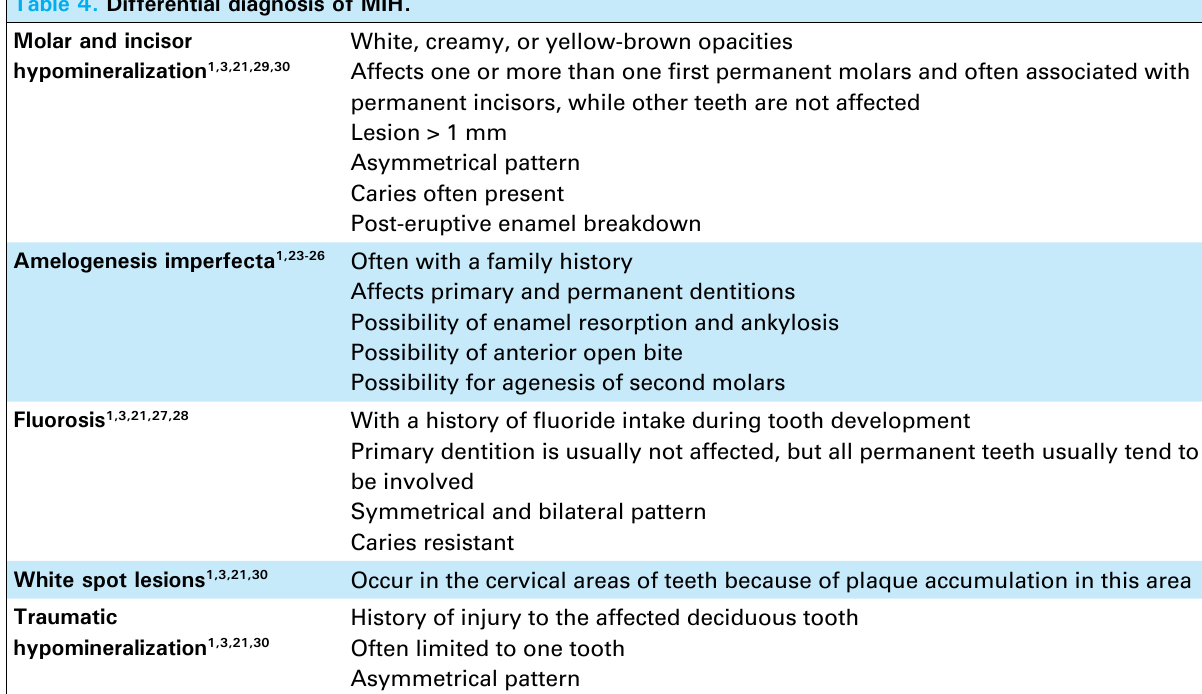
Table 4. Differential diagnosis of MIH. Molar and